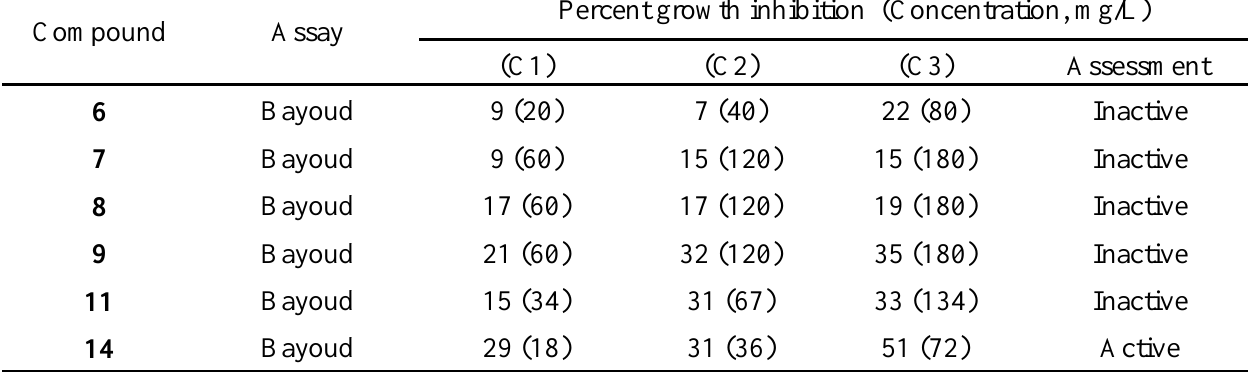
Table 1 . Antifungal activity of selected quinoxaline compounds 6-9 , 11 and 14